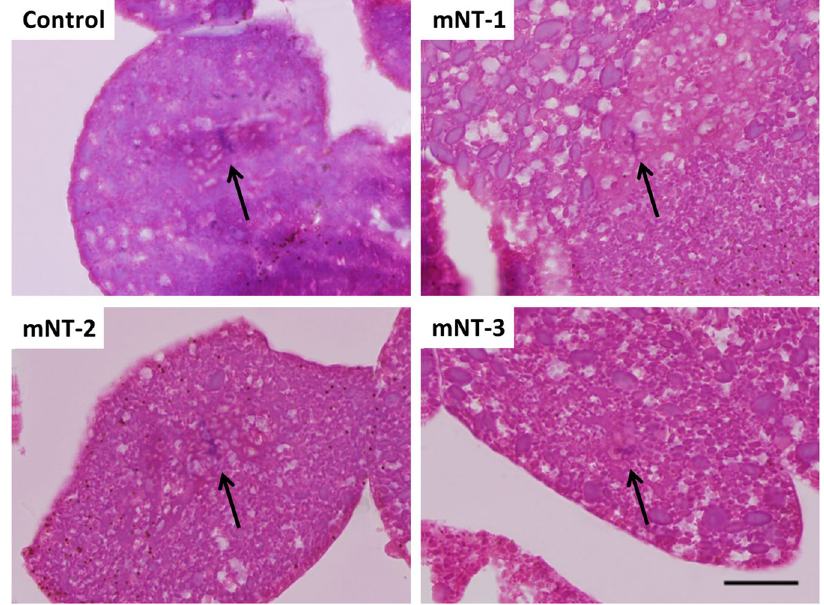
Figure 2. Histological sections of early blastula stage (256-cell) sterlet embryo (Control) and three Russian sturgeon mNTs (mNT-1, mNT-2 and mNT-3) at the same age. Black arrows indicate the location of the nuclei inside single blastomeres. Scale bar corresponds to 25 μ m.